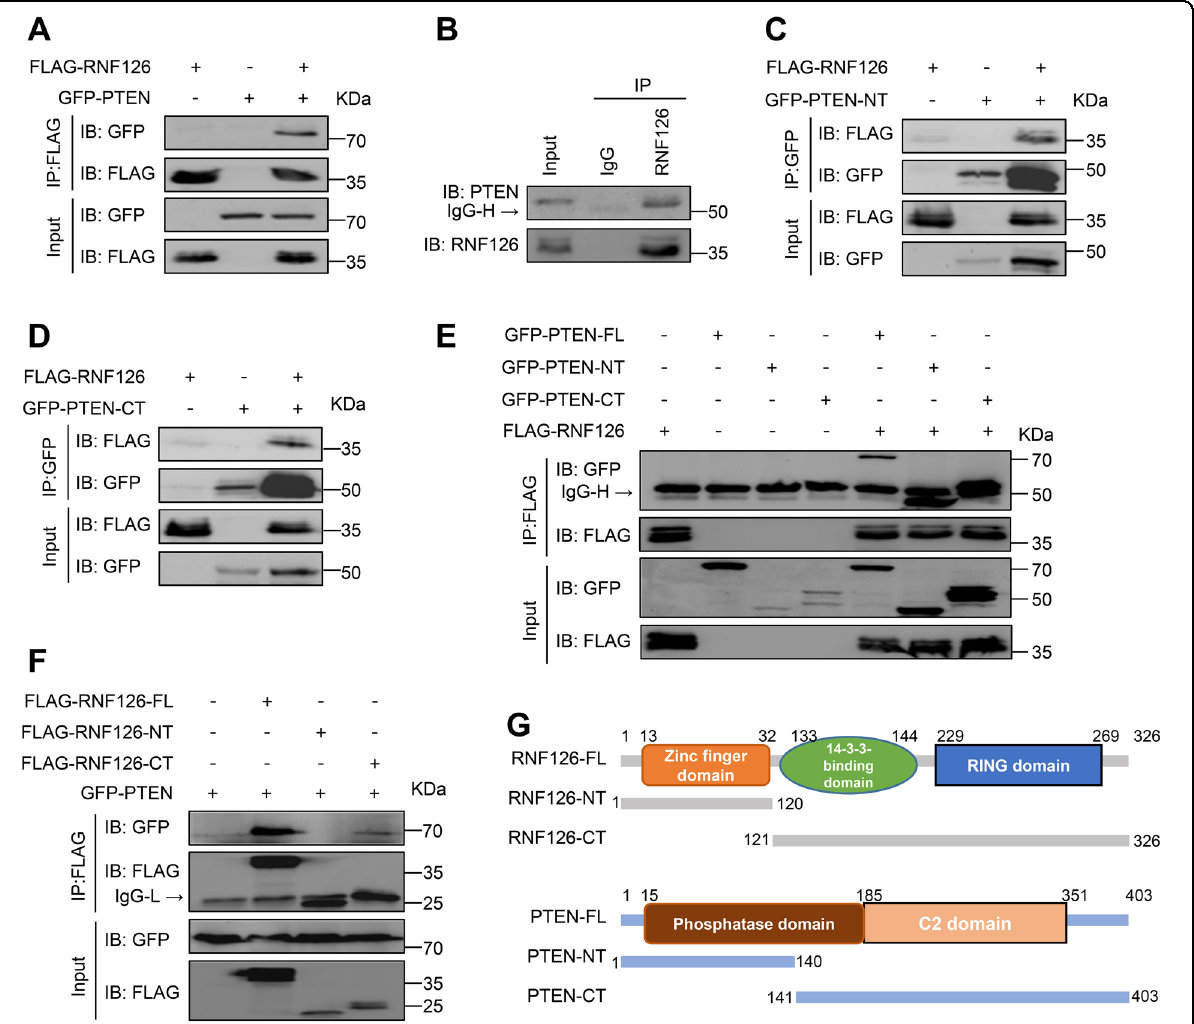
Fig. 4 RNF126 interacts with PTEN. A The co-immunoprecipitation of GFP-PTEN and FLAG-RNF126 in 293T cells. The 293T cells were transfected with FLAG-RNF126 and GFP-PTEN plasmids for 36 h. B The endogenous co-immunoprecipitation of PTEN and RNF126 in T24 cells. C – E The interactions between full-length RNF126 and truncated forms of GFP-PTEN were observed by co-immunoprecipitation in 293T cells. F The interactions between full-length PTEN and truncated forms of FLAG-RNF126 were observed by co-immunoprecipitation in 293T cells. G Protein domains of RNF126 and PTEN. Numbers indicate how long the proteins were cut off. RNF126 protein was truncated between the RING fi nger domain and the Zn fi nger domain. PTEN protein was truncated to reserve the C2